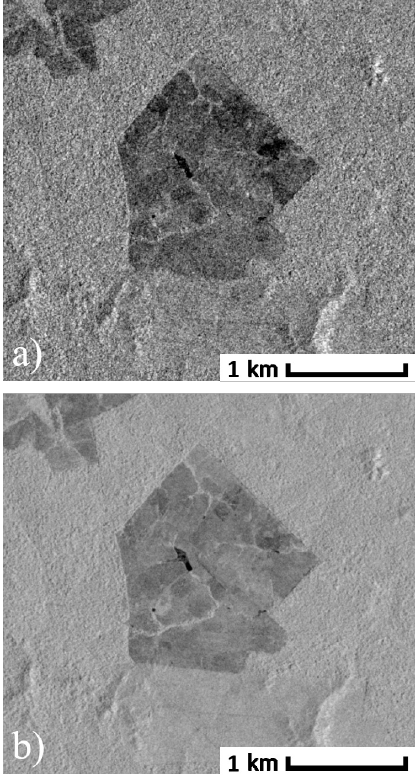
Figure 3. a) VV polarization one scene and b) VV dry coefficient from 10